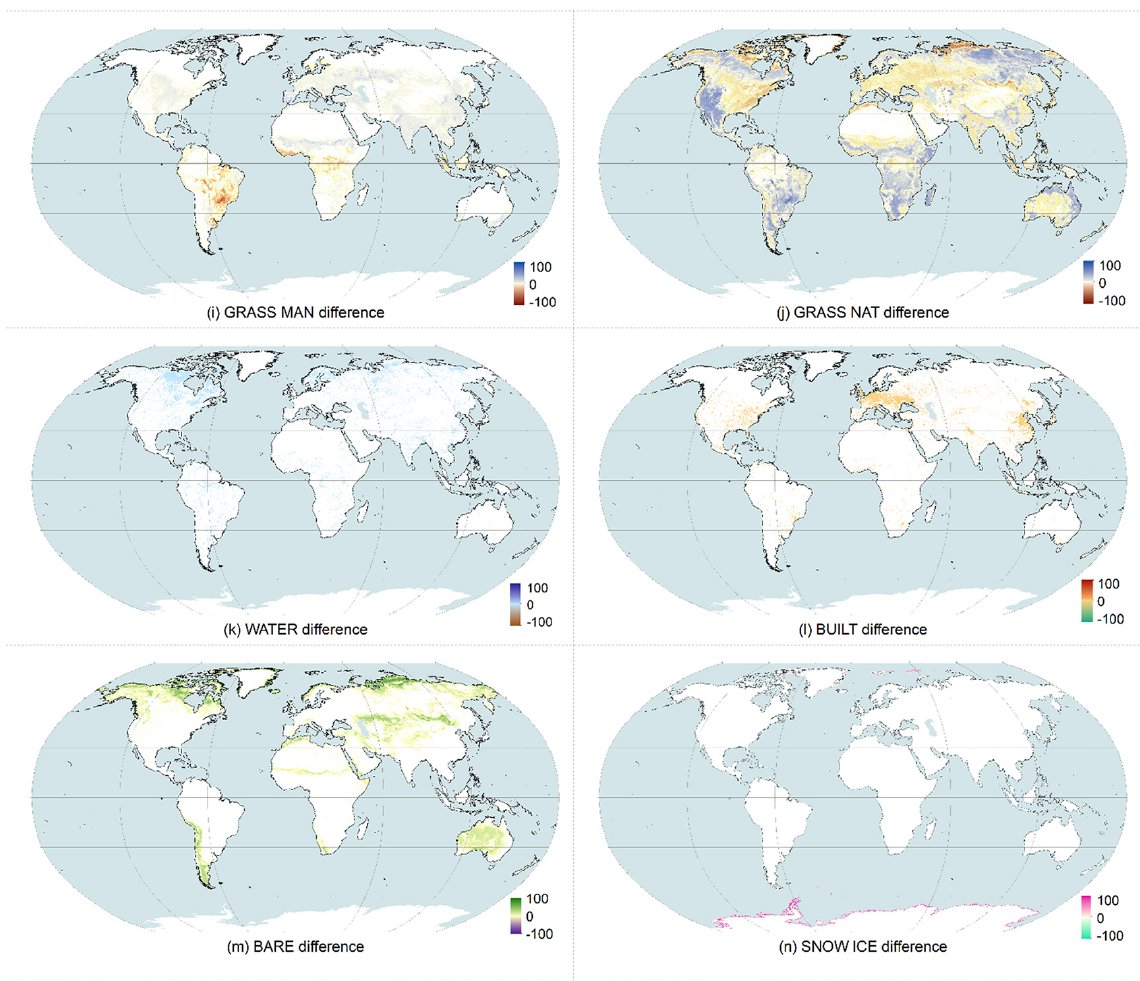
Figure A2. Absolute differences (percentage of pixels) between the 2010 PFT local dataset and the corresponding PFT global maps (i.e. applying the global cross-walking scheme) for the 14 PFT types. The spatial resolution is 0 . 25 × 0 . 25 ◦